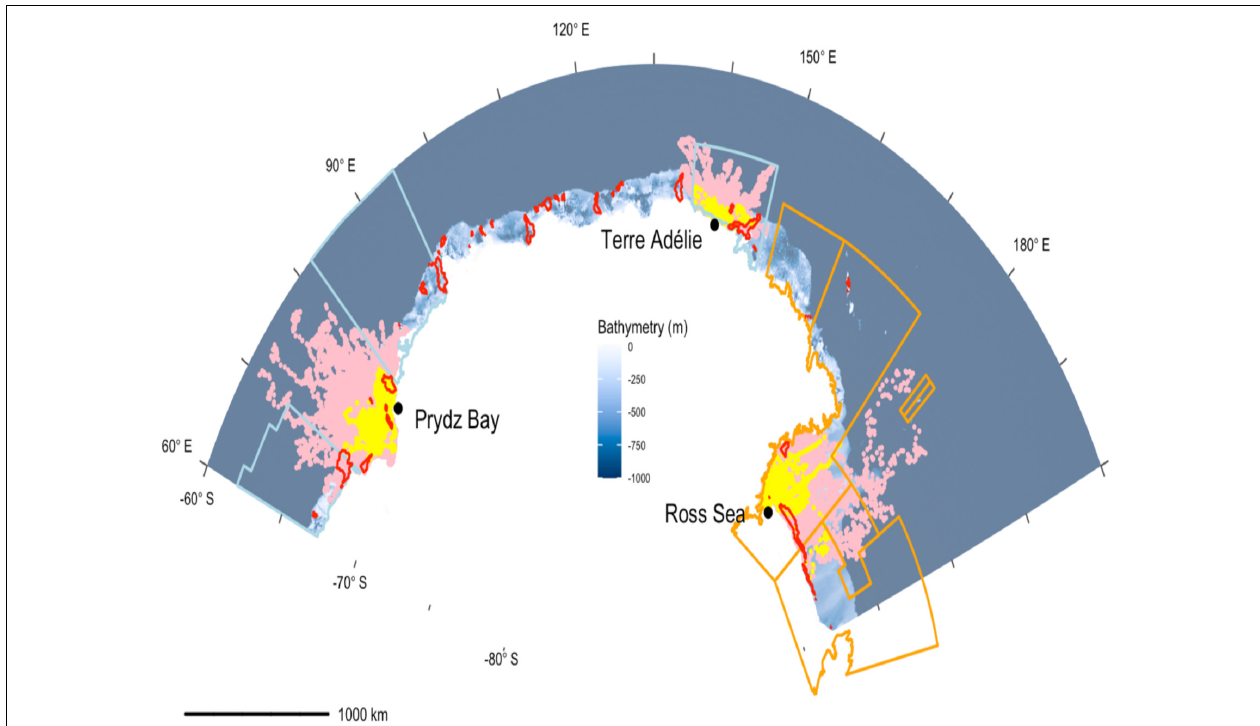
FIGURE 1 | Maps of the estimated daily locations (yellow points) of 78 Weddell seals tracked over the winter months in three regions (Prydz Bay, Terre Adélie, and Ross Sea). The blue background represents the GEBCO19 bathymetry. Recurrent polynyas (from Arrigo and van Dijken, 2003) are outlined in red. The orange line outlines the existing Ross Sea Marine Protected Area and the light blue line outlines the proposed East Antarctica Marine Protected Area (MPA). The pink dots indicate the regions accessible to the seals based on simulated